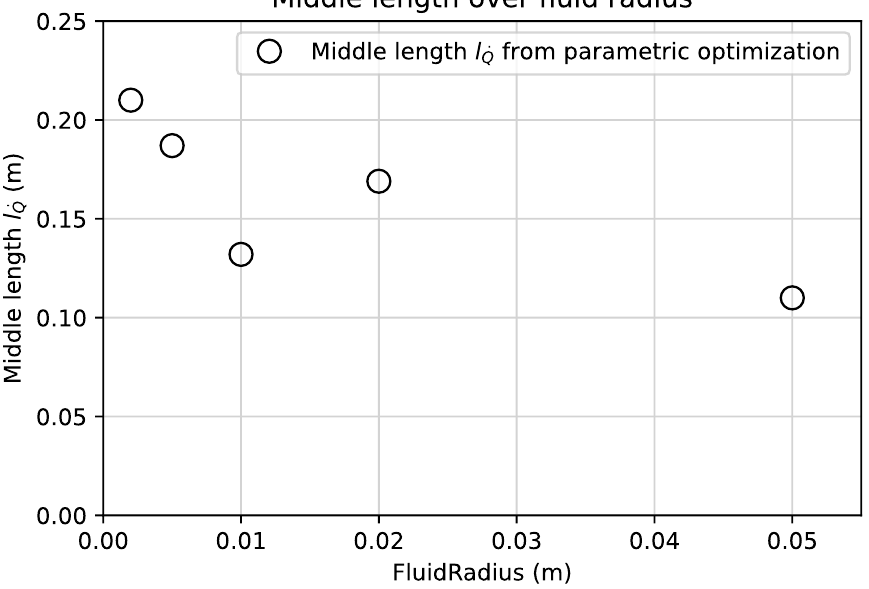
Figure 13. Resulting l ˙ Q from the optimization over the fluid radius r